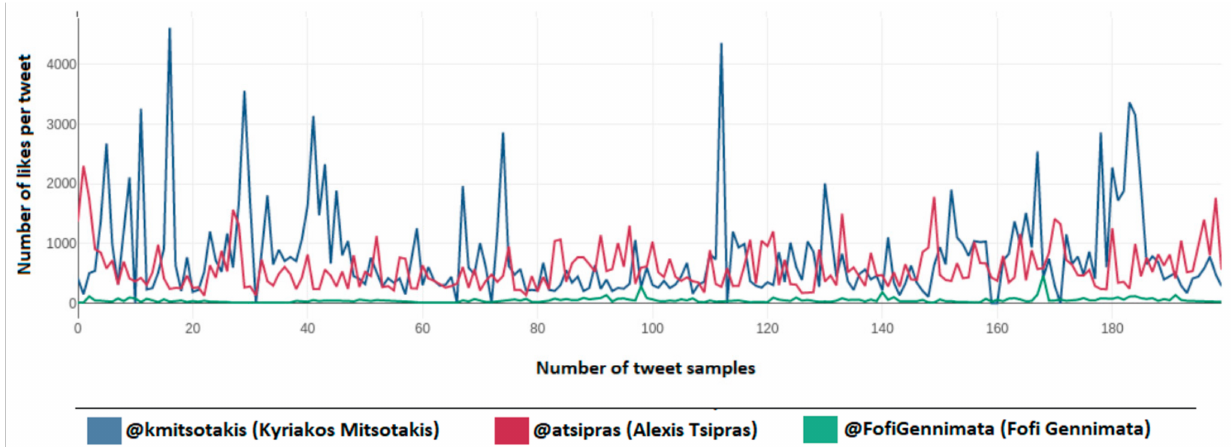
Figure 30. Comparison of user likes per posted tweet for the top three Greek political leaders—600 tweet sample; 200 for each one of them (@primeministerGR is excluded).